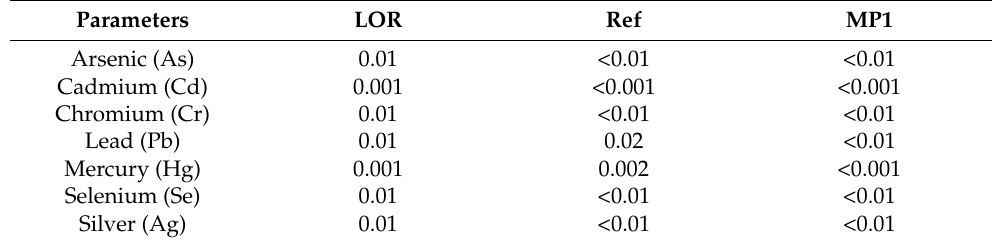
Table 13. Leaching compliance test results (mg parameter/kg solid